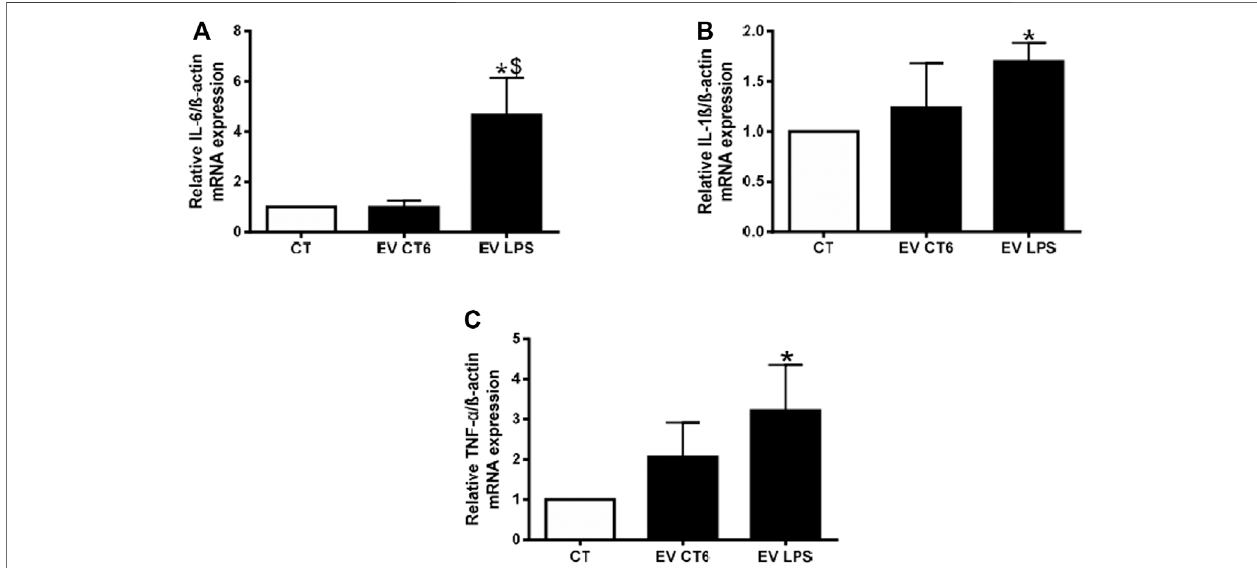
FIGURE 7 | EV-LPS increases cytokine gene expression in smooth muscle cells. MOVAS-1 cells were incubated with RAW cell-derived EVs for 24 h. Gene expression of (A) IL-6, (B) IL-1ß, and (C) TNF- α was then quanti fi ed by quantitative real-time PCR and normalized to that of the housekeeping gene ß-actin. Data are expressed as the mean ± SEM of four independent experiments performed in triplicate ( n = 4). * p < 0.05 vs . CT, $ p < 0.05 vs . EV-CT, Mann-Whitney test. EV-CT: EV- derived from untreated macrophages, EV-LPS: EV-derived from LPS-EK-treated macrophages.